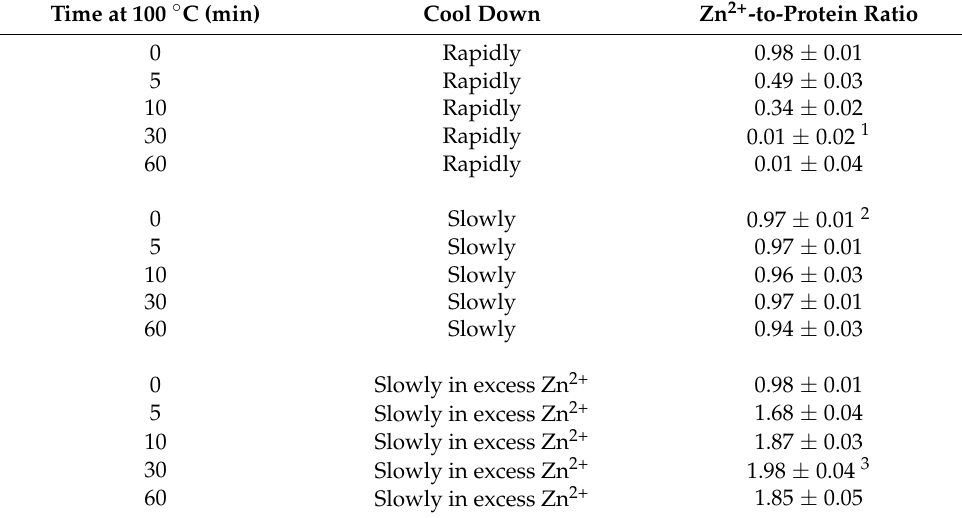
Table 1. Zn 2+ -to-protein ratio of treated NCp7. Time at 100 ◦ C